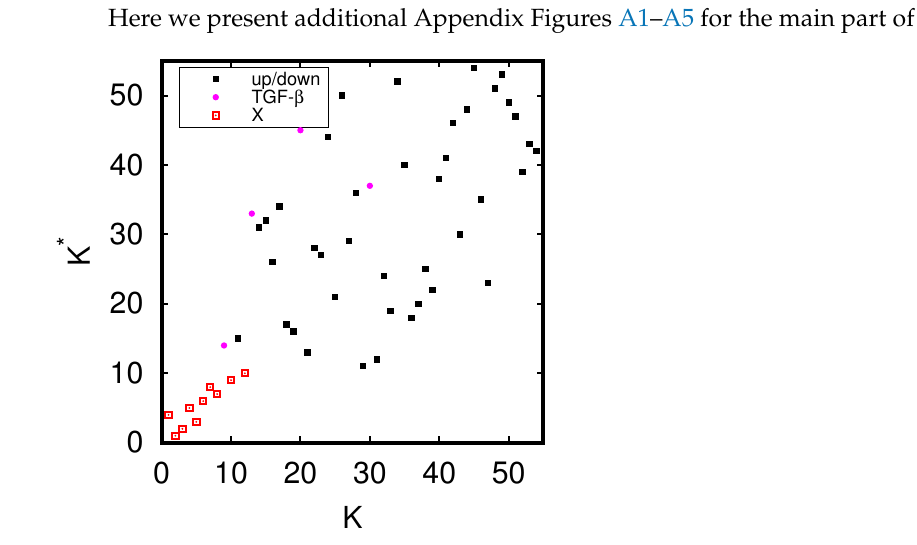
( 166 ) for the intermediary group ab